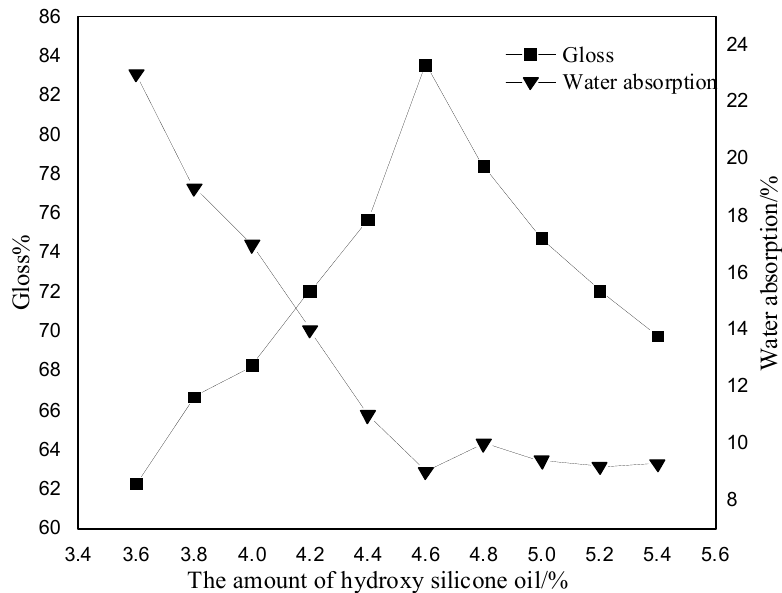
Figure 6. Effect of the amount of hydroxy silicone oil on gloss and water absorption.